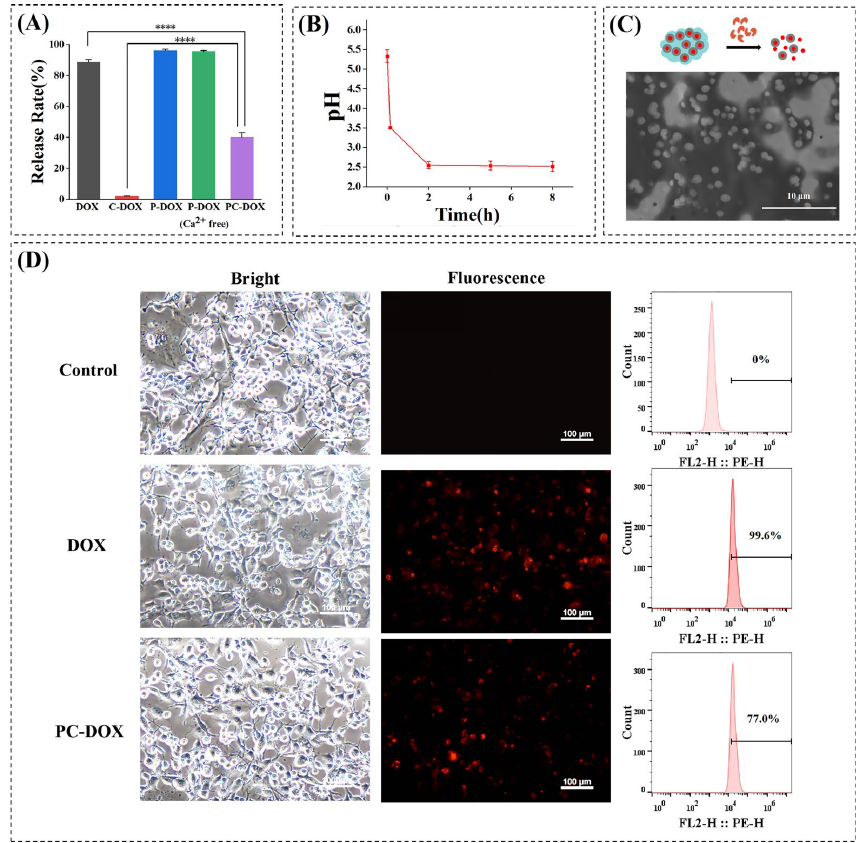
Figure 3. ( A ) Drug-release rates of PC−DOX and other control groups after the addition of pectinase